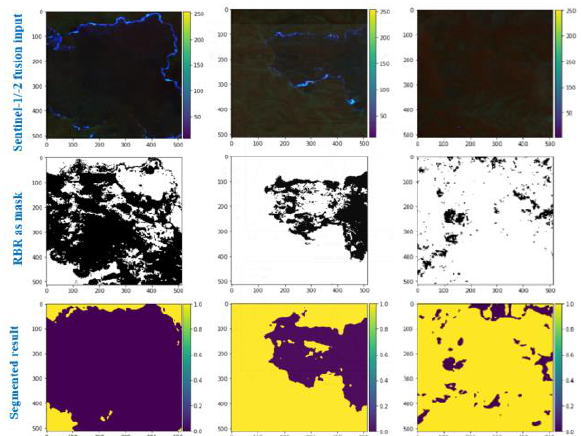
Figure 9. The images in first row are the S1 and S2 fused and tiled images as model input data, the second row demonstrates the tiles mask/labelled image based on processed RBR image (as ground truth), and the last row represents the U-net semantic segmentation maps.